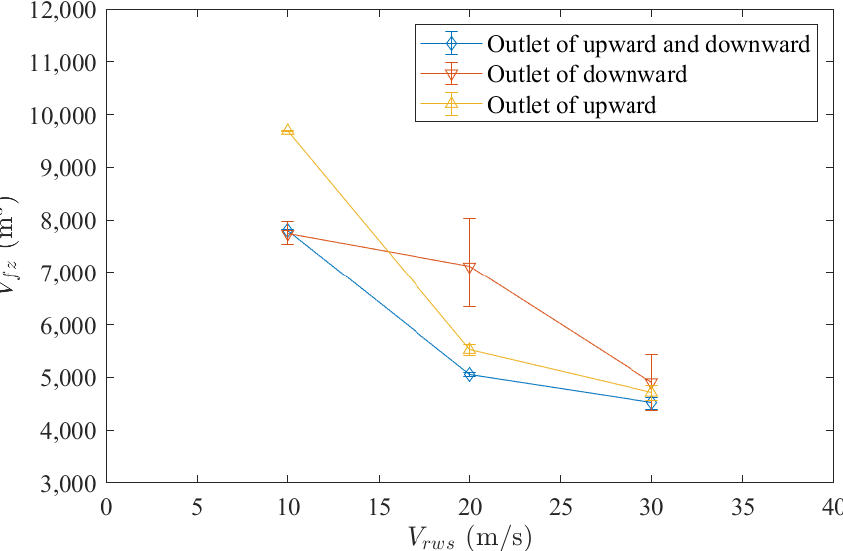
Figure 11. Total volume of FZ ( V fz ) for three kinds of vent-mast outlet directions based on relative wind speed ( V rws ); the scenario of emissions from all of the four vent masts is shown.